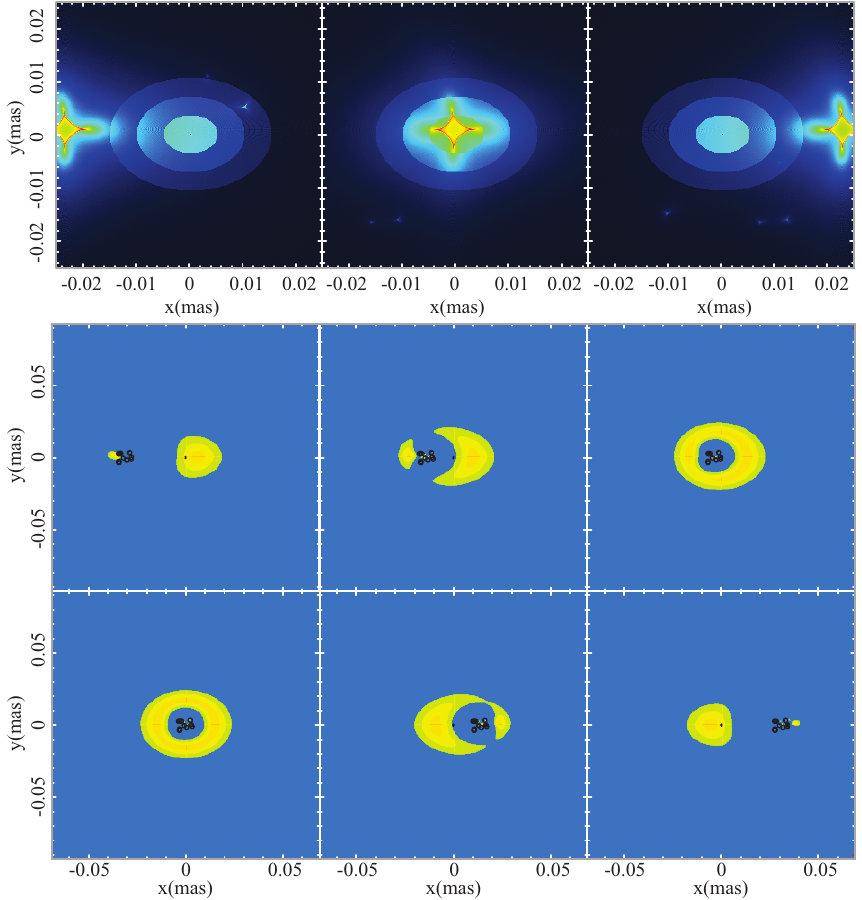
Fig. 1. Upper panel . Multi section source and magnification pattern, for three different positions during the crossing. Lower panel . Deviations of the lens image due to microlensing in a system of 10 solar-mass